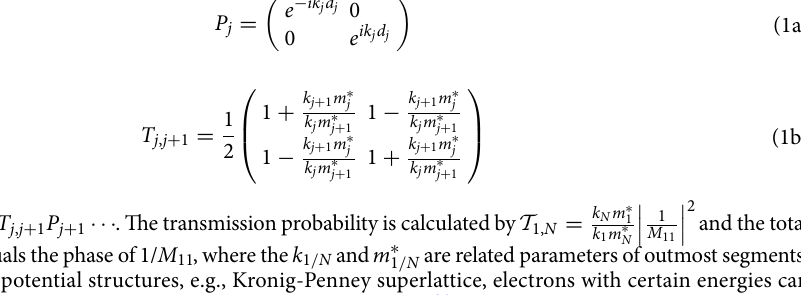
(cid:31) − m ∗ and V are the effective mass of electron and potential, respectively. The solution is the forward traveling wave Ae ikx or the backward traveling one Be − ikx due to the absence of reflection, where the wavevector is [ E √ 2 m ( x ) k V ( x ) ] / ℏ . ∗ × = −